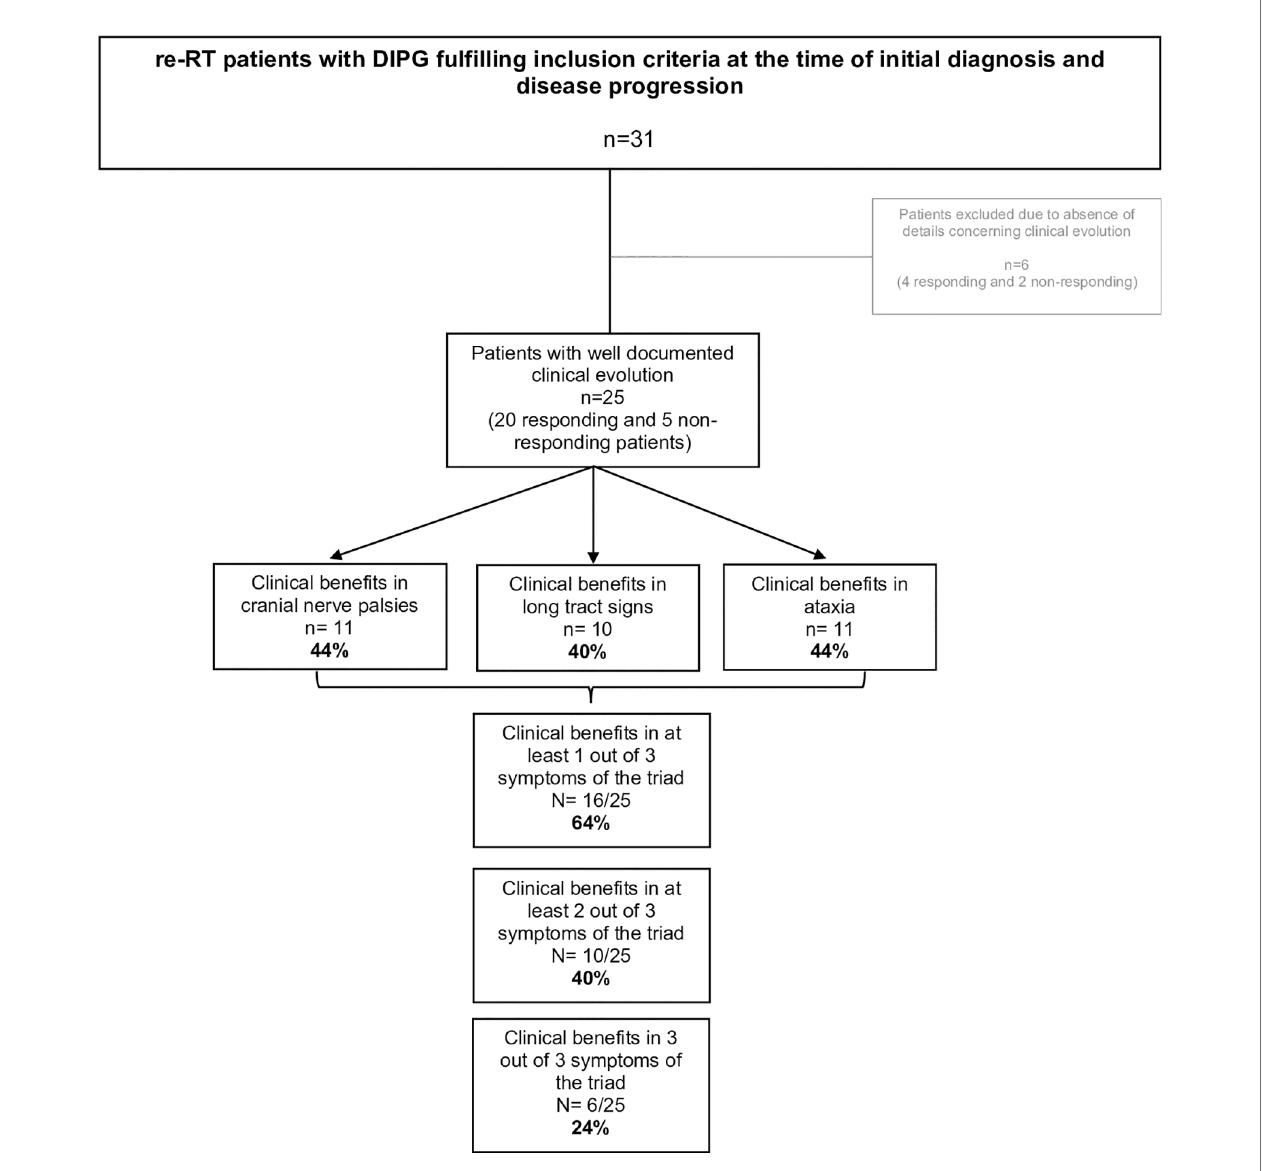
FIGURE 2 | DIPG triad symptom evolution after